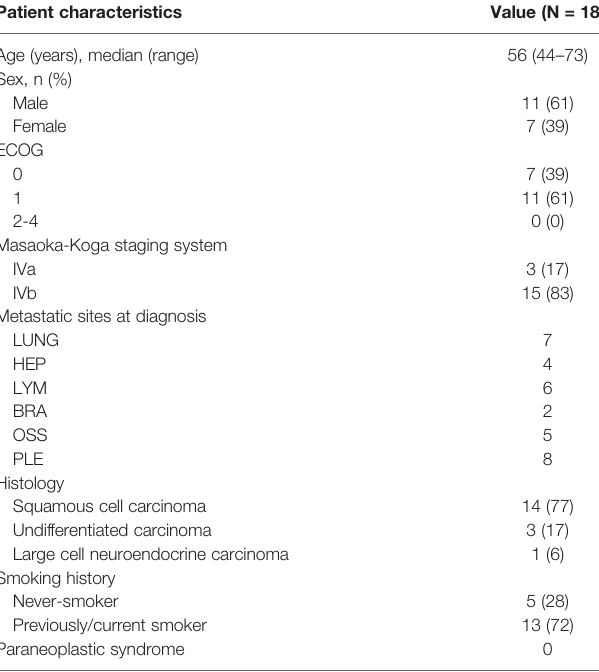
TABLE 1 | Patient characteristics. TABLE 2 | Delivery methods of fi rst- and later-line chemotherapy and response to cisplatin and irinotecan combination